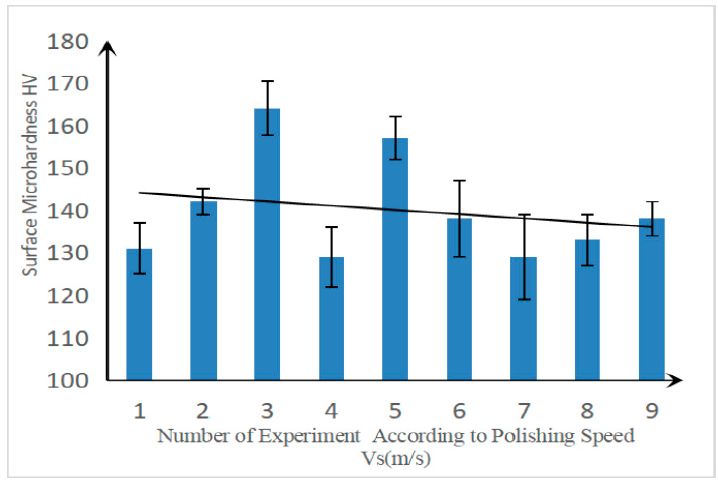
Figure 18. Relationship between the surface micro-hardness and the belt line speed.